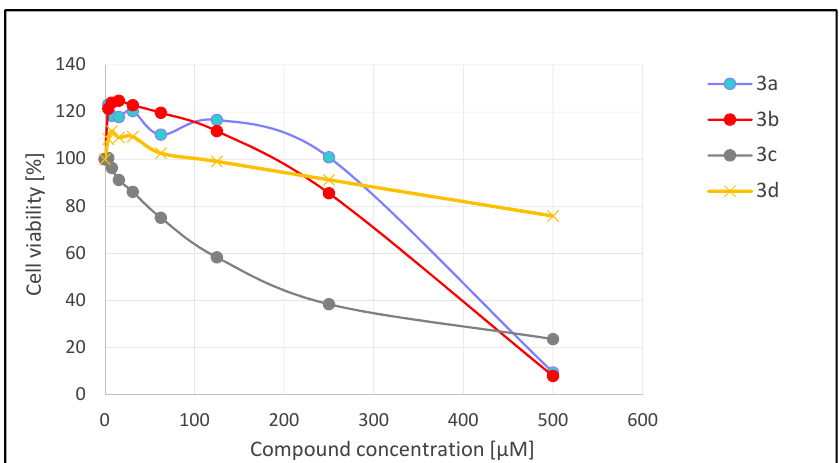
Figure 5. Cytotoxicity of arene-ruthenium(II) complexes ( 3a – 3d ) against the HFF-1 human foreskin fibroblast line measured by MTT method. The results are presented as mean percentage of cell viability in comparison to untreated cells (positive control), taken as 100%.